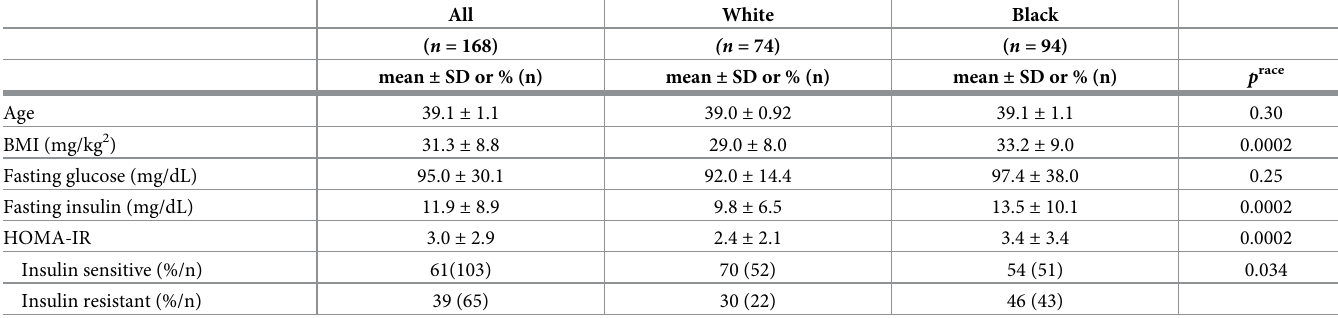
Table 1. Participant